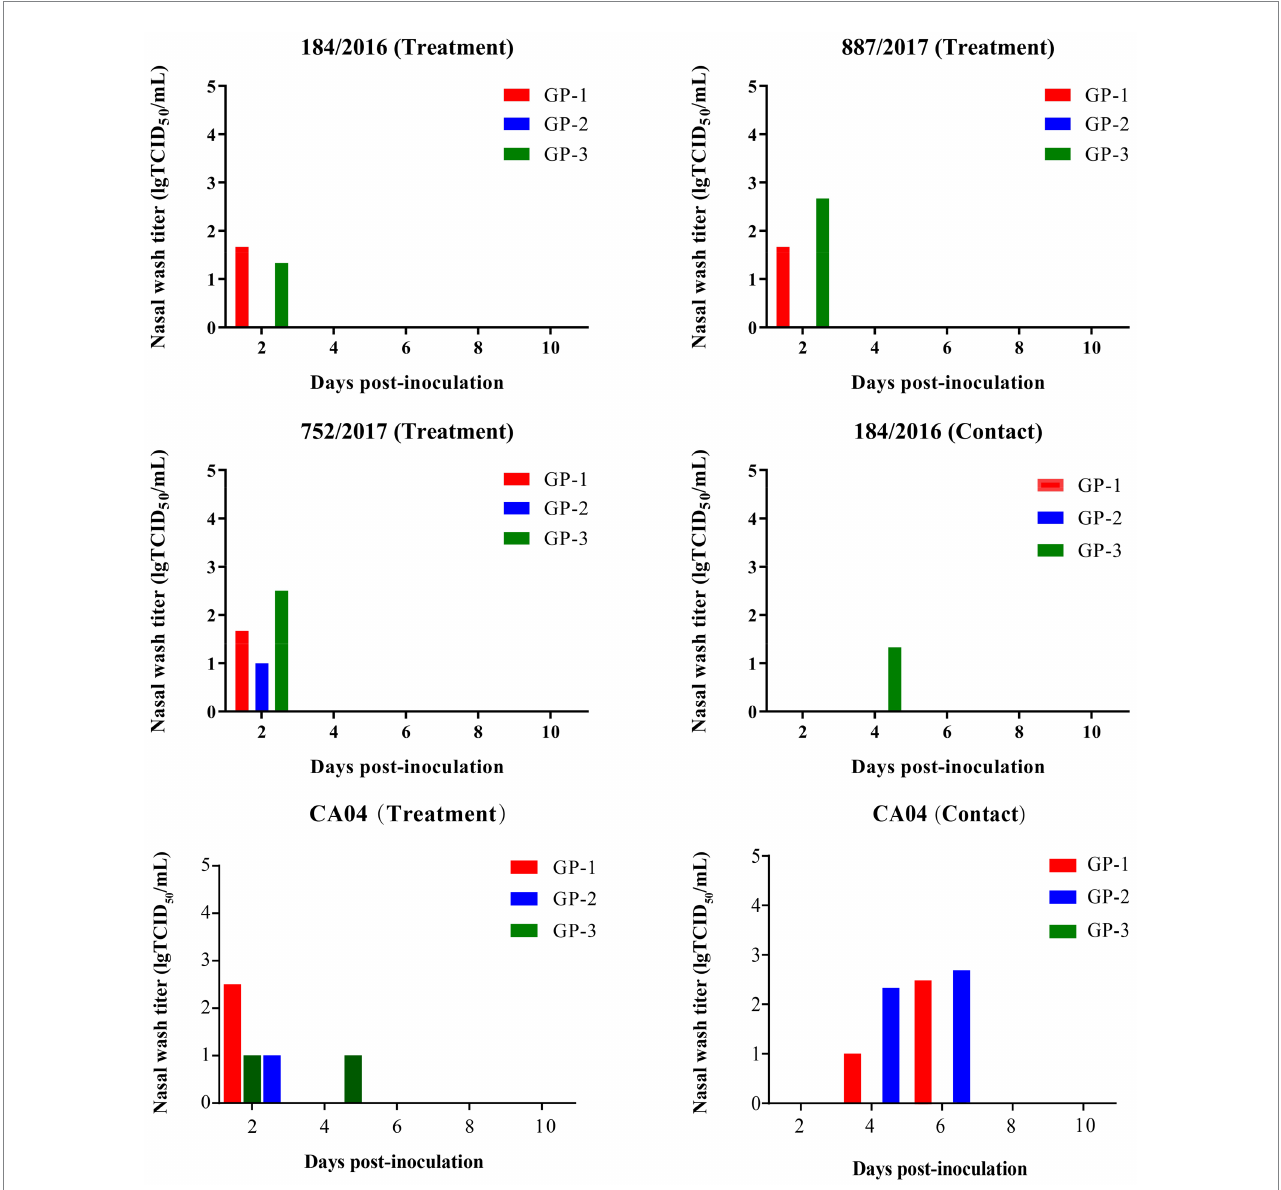
FIGURE 6 Transmission of 887/2017, 752/2017, 184/2016, and CA04 viruses among guinea pigs. Twelve female, 6-week–old, SPF Hartley strain guinea pigs were randomly divided into three groups and each group includes three guinea pigs. Groups of guinea pigs were intranasally inoculated with 887/2017, 752/2017, 184/2016, and CA04 at a dose of 10 6 TCID 50 in 300 μ L under anesthesia, respectively. At 1 DPI, three naïve guinea pigs were co-housed with three infected guinea pigs in the same cage. The nasal washes of guinea pigs were collected at 2, 4, 6, 8, and 10 DPI and were titrated in MDCK cells. The sera were collected at 21 DPI for HI